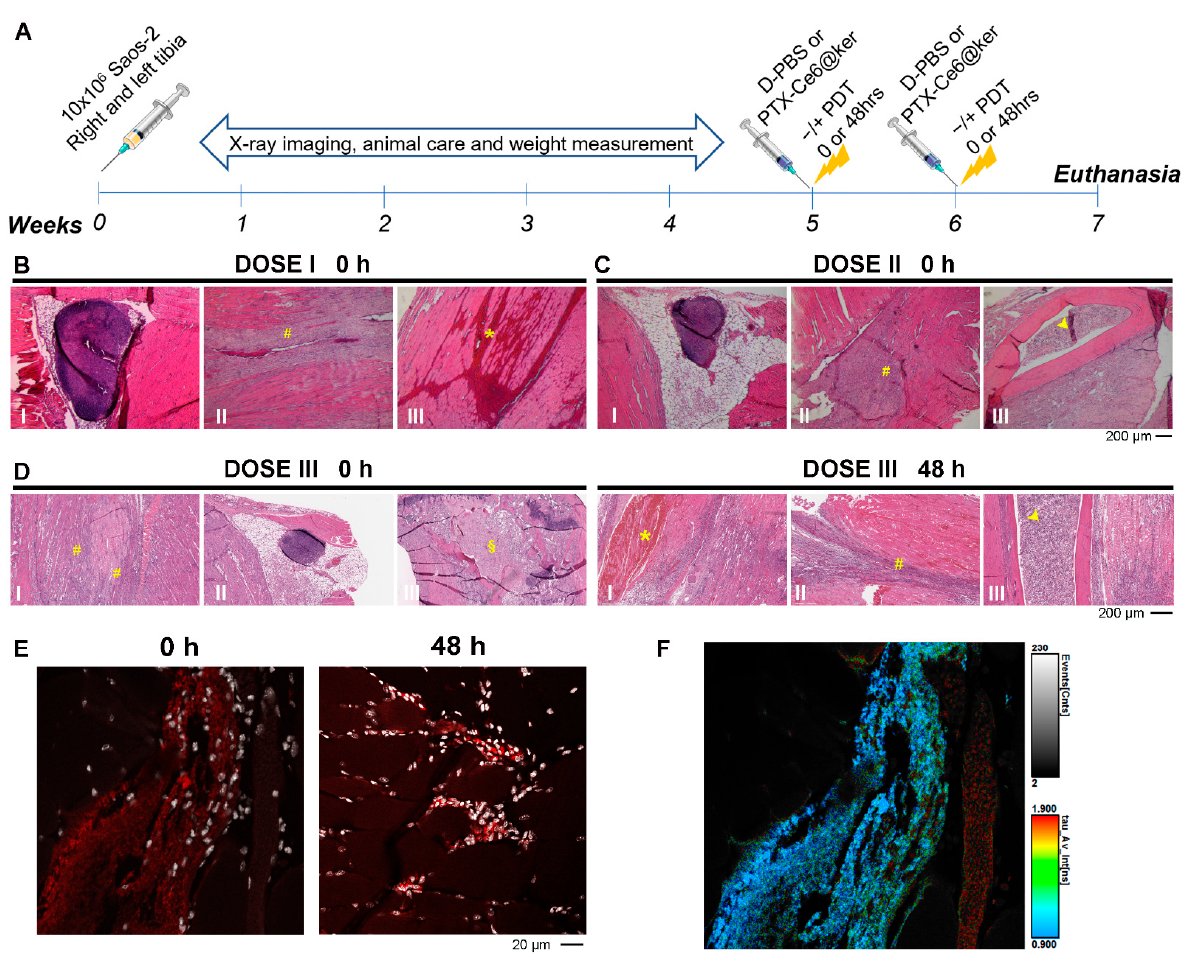
Figure 5. Treatment regime set up: nanoformulation dosage and treatment’s schedule. ( A ) Timeline of the treatment regimen. ( B – D ) Histological evaluation of tumor tissue after treatments. Representative brightfield images of paraffin sections stained with H&E from samples treated with DOSE I ( B ), DOSE II ( C ) and irradiated immediately after (0 h), and of DOSE III ( D ) irradiated at 0 h and after 48 h. ( E ) Representative confocal images of samples from mouse treated with DOSE III and euthanised immediately (0 h) or 48 h after treatment. The red signal corresponds to the Ce6 molecule, while nuclei are shown in white. ( F ) Representative figure of FLIM analysis showing the Ce6 signal distribution in the tissue area right after PTX-Ce6@ker inoculation (time 0 h) with the colour scale indicating the average lifetime. The blue regions with τ av of around 1 ns are indicative of Ce6, while the red-coloured regions, characterized by a τ av of > 2 ns, are indicative of autofluorescence and Hoechst staining in the nuclei.